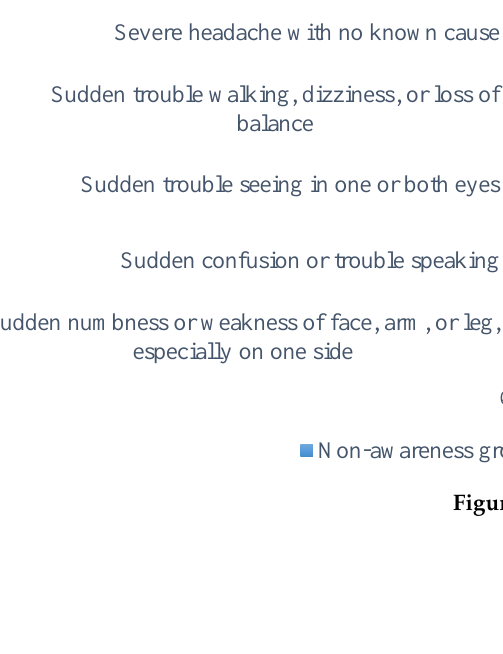
Figure 2. Percentage of participants who recognized each symptom of the Knowledge of CVDs warning signs. 3.3. Factors Associated with KCVDs and AoBP Factors associated with KCVDs warning signs are listed in Table 3. Among women with HTN, more BP level awareness was associated with better KCVDs (OR = 1.121, p < 0.001). Middle-age (OR = 1.046, p = 0.008), employment (OR = 1.034, p = 0.017), and married and living with a spouse (OR = 1.068, p < 0.001) were associated with better KCVDs. In addition, lower levels of education (OR = 0.931, p < 0.001) and regular walking (OR = 0.964, p = 0.015) were associated with lower KCVDs. Table 3. Factors associated with knowledge of the cardio-cerebrovascular disease. Variables